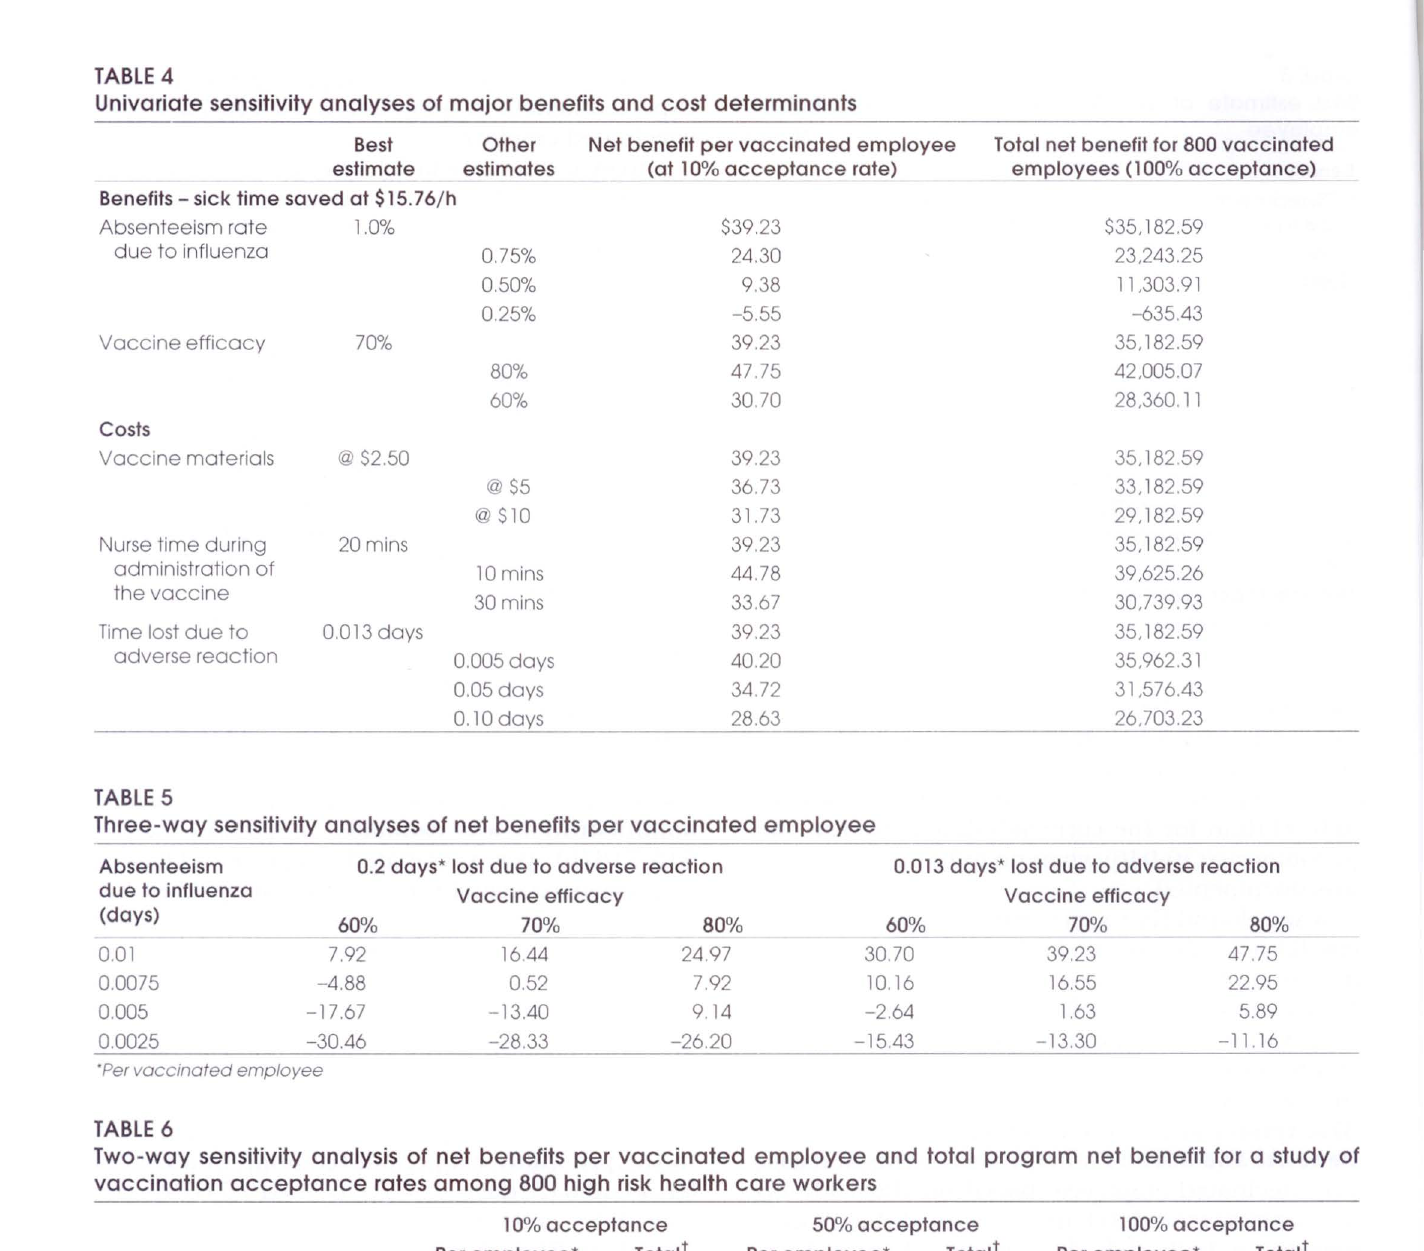
Two-way sensitivity analysis of net benefits per vaccinated employee and total program net benefit for a study of vaccination acceptance rates among 800 high risk health care